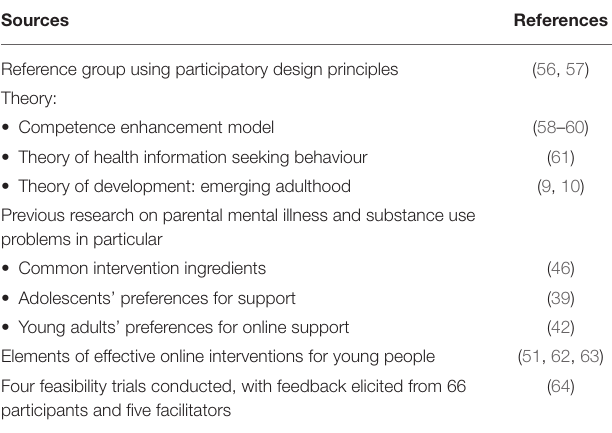
TABLE 1 | How mi.spot was